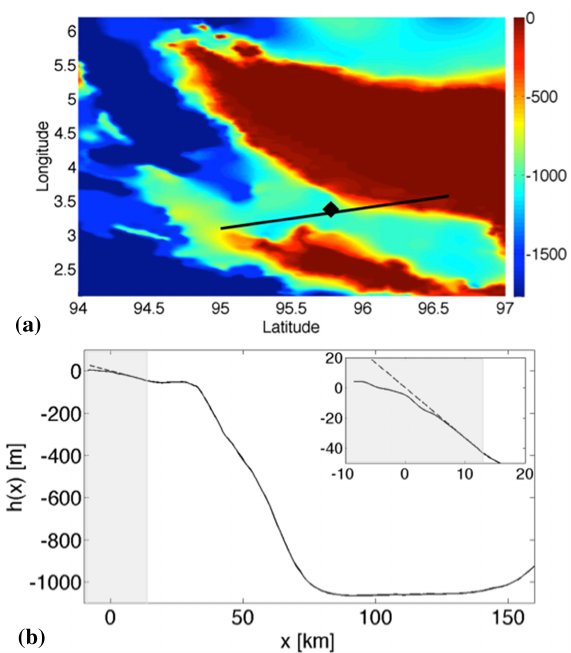
Fig. 16. Free-surface profiles of Aceh simulations with the linear model (left: LSWE, right: LVBM) coupled to the NSWE are shown by the dashed and dotted-dashed lines and of simulations for a linear model with an EBC implementation are shown by the solid line at times (a) t = 800s , (b) 1600 s , (c) 2700 s , (d) 3200 s , (e) 4000 s , (f) 5400 s . The solid and dashed lines are on top of another.